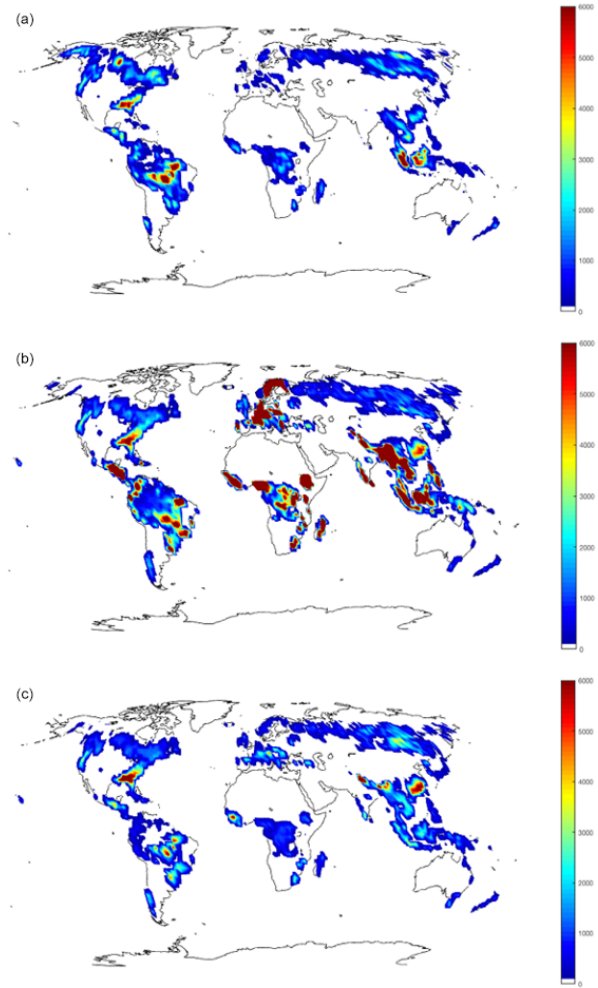
Figure 6. Forest loss 2000–2012: (a) Landsat forest loss (Hansen et al. 2013), (b) LUH2 forest loss without Landsat constraint, and (c) LUH2 forest loss with Landsat